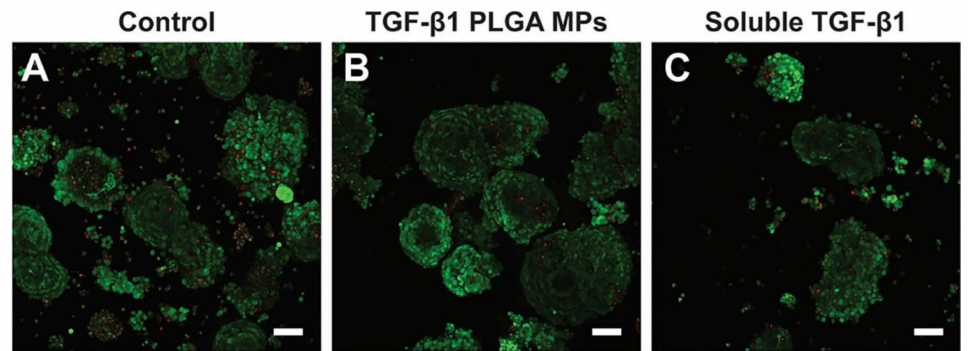
Figure 9. The biocompatibility study of TGF- β 1/PLGA MPs with rat islet cells, ( A ) control islets, ( B ) islets incubated with TGF- β 1 PLGA microparticles, ( C ) islets incubated with soluble TGF- β 1, Red = dead cells, Green = viable cells [90]. Copyright 2021,